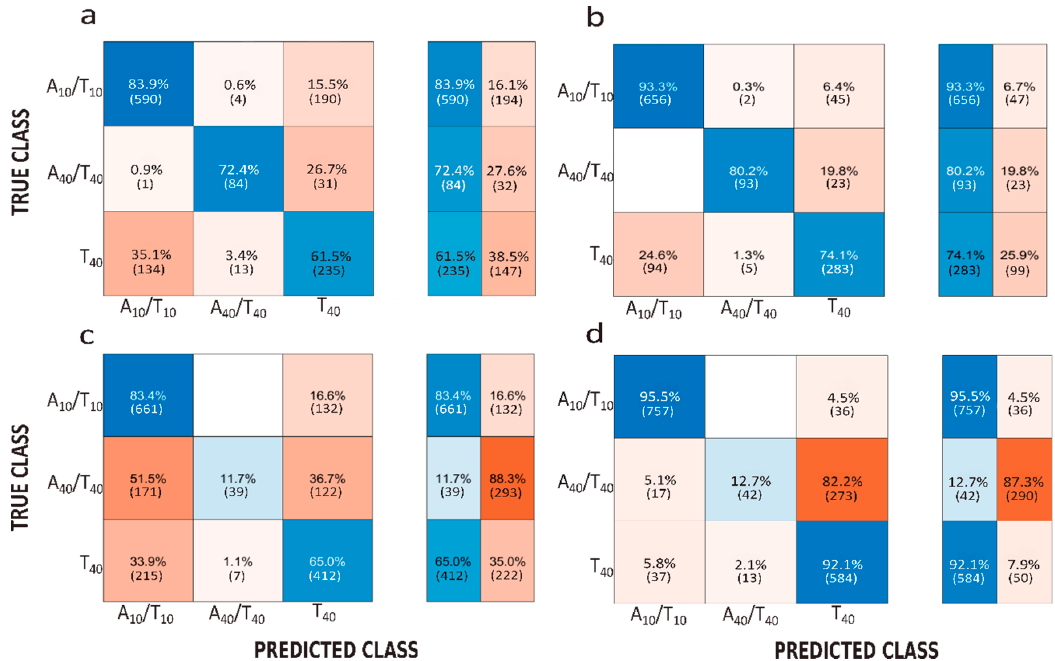
Figure 6. Confusion matrices representing the accuracy of classification with the support vector machine approach obtained under V = 250 mV using ( a ) 2 features ( Δ I/I 0 , Δ t ) and ( b ) 5 features ( Δ I/I 0 , Δ t , AUC, LS, RS ) and under 500 mV using ( c ) 2 features ( Δ I/I 0 , Δ t ) and ( d ) 5 features ( Δ I/I 0 , Δ t , AUC, LS, RS ). The results were obtained using pore 1 d t = 3 nm, d b = 200 nm.